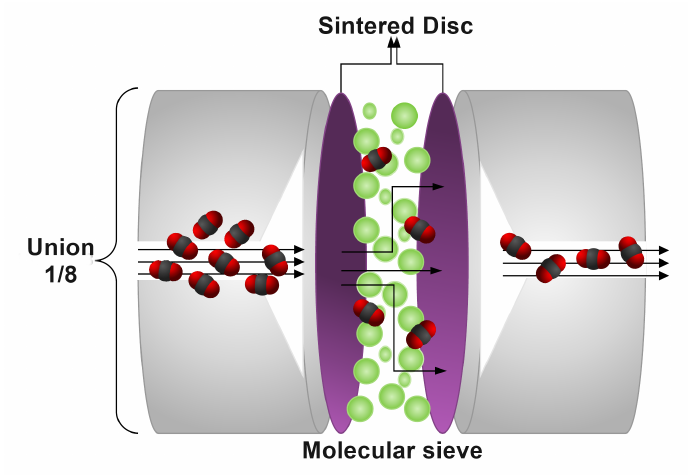
Figure 2. Schematic diagram of the zero length